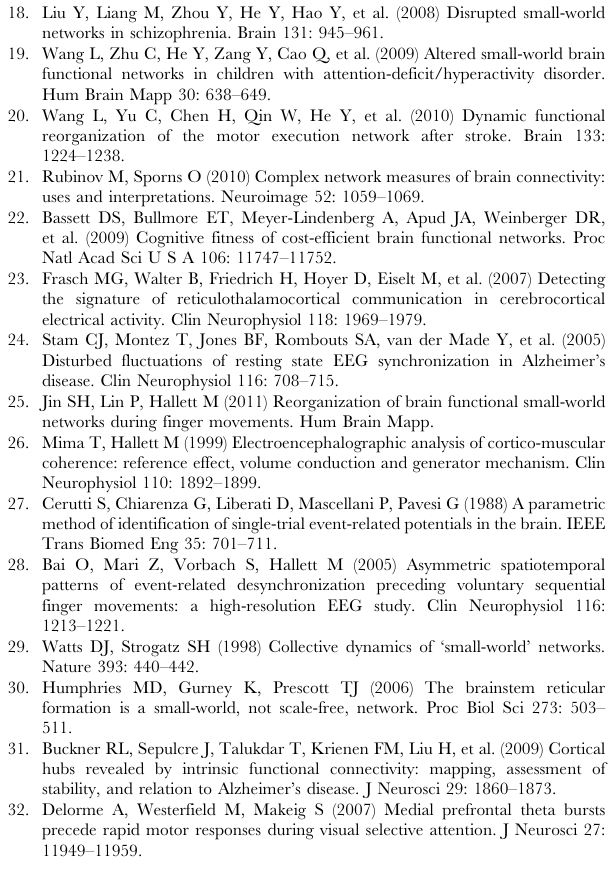
Figure S4 Box-plots showing median, interquartile, and range for Elocal in each group and condition at a cost 0.28, which shows the most significant interaction effects of group and condition on Eglob . No significant differences were found. Table S1 Correlation coefficients R and p values between Eglob , Elocal and age at each cost in the range of 0.16 , C , 0.50 in the beta network. No correlations were found. Table S2 Correlation coefficients R and p values between max CE and age in the beta network. No correlations were found. Text S1 Wavelet coefficients and mutual information